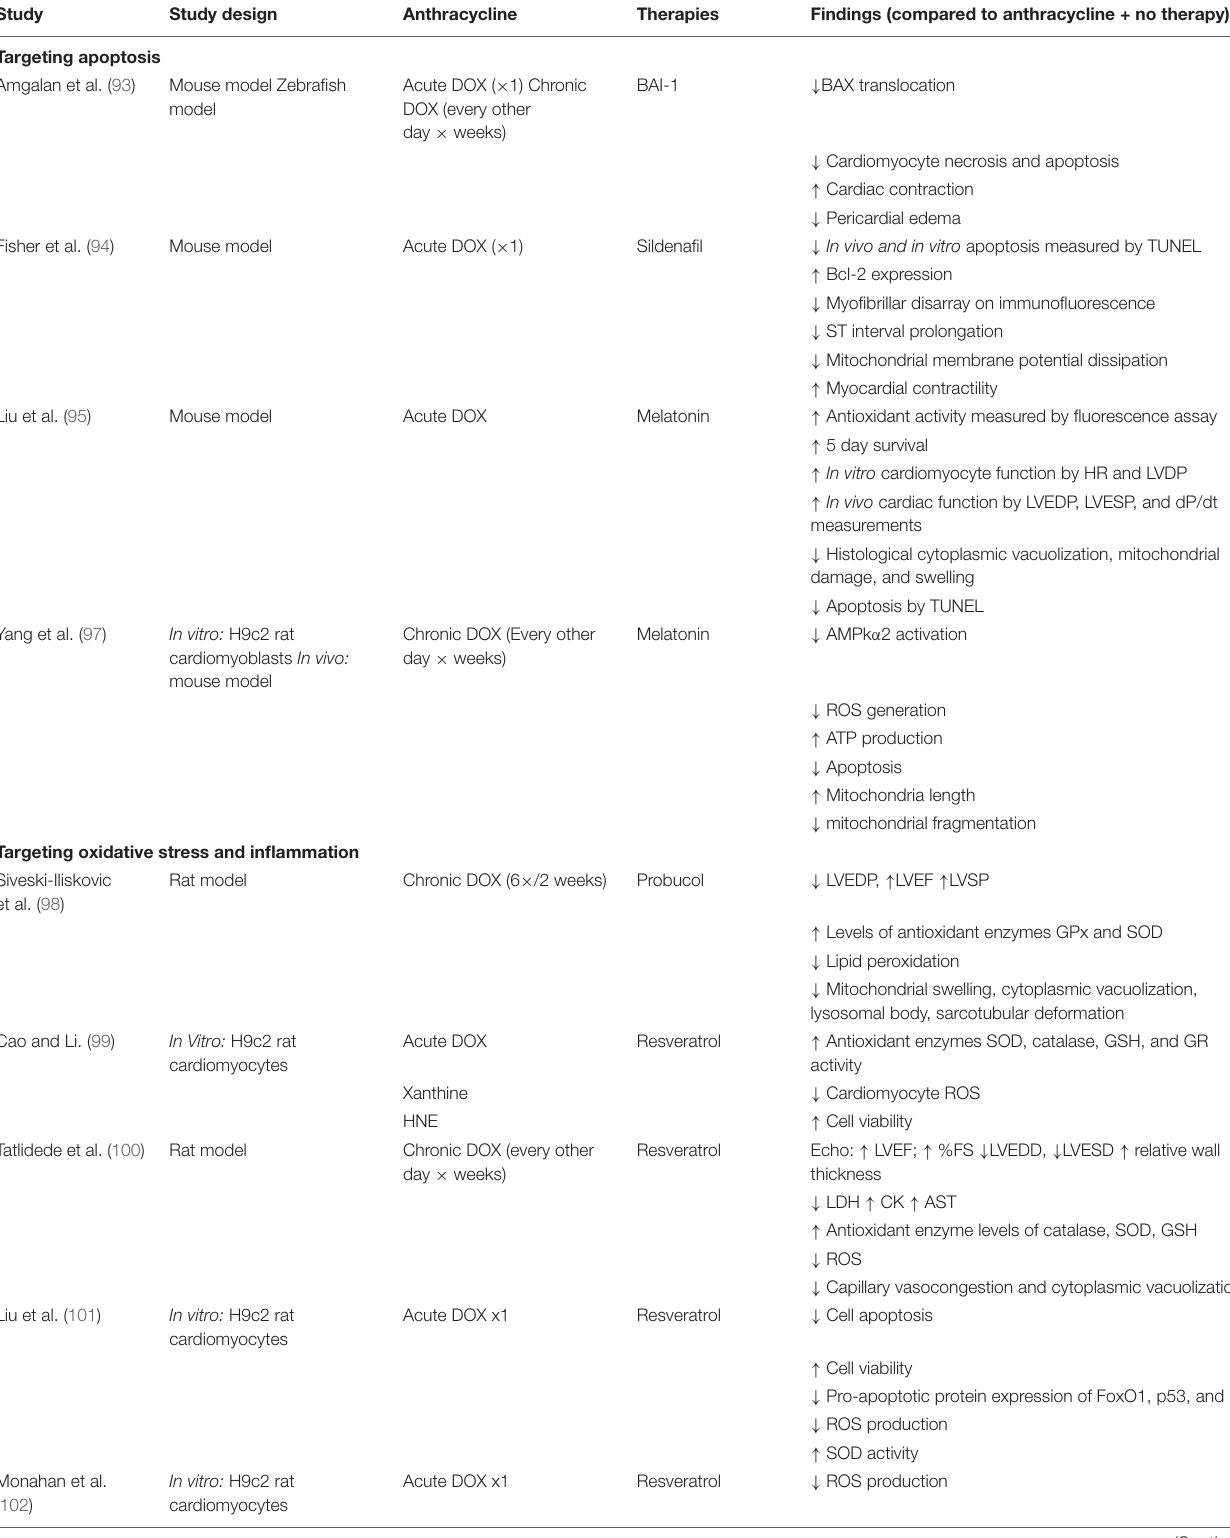
TABLE 3 | Summary of findings from clinical and preclinical studies for investigational therapies.